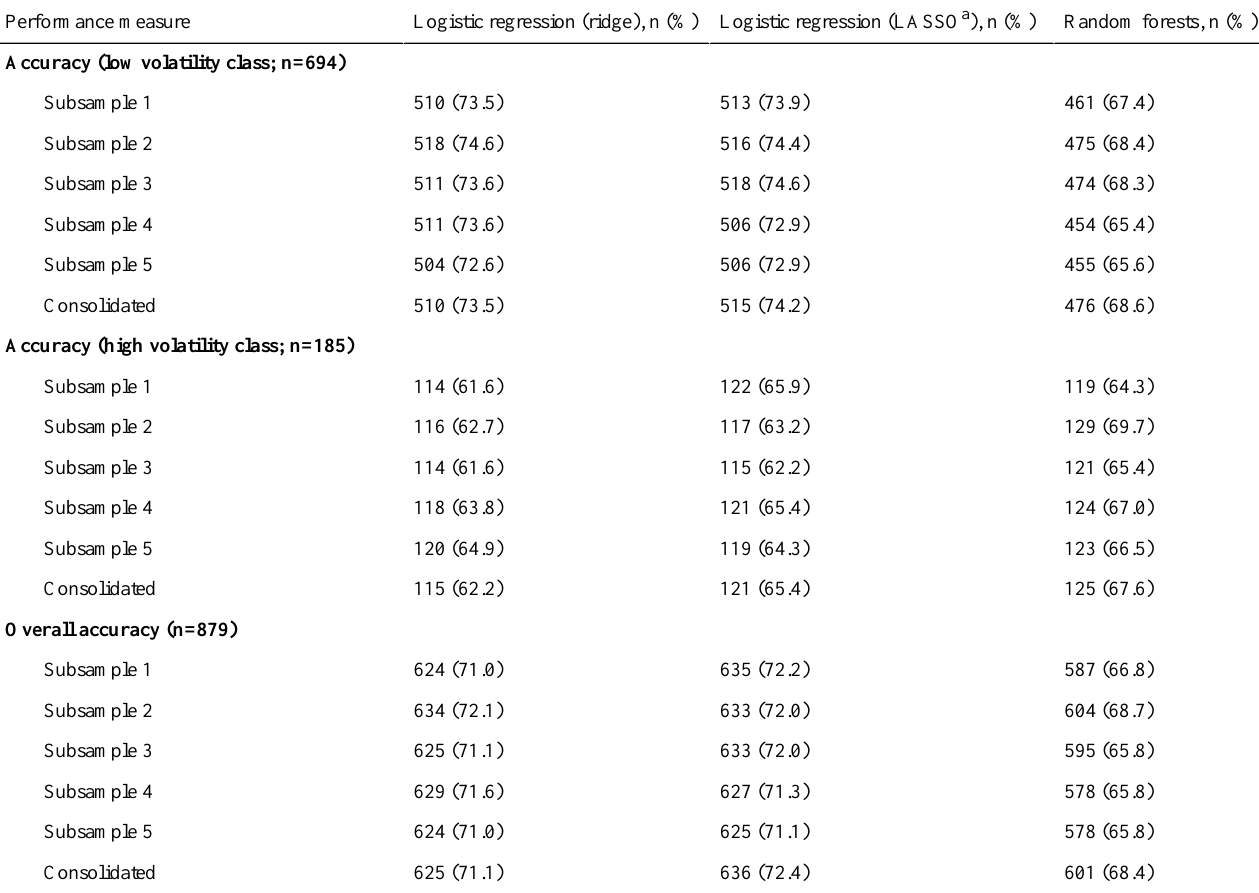
Table 2. Prediction performance using the 9 selected important